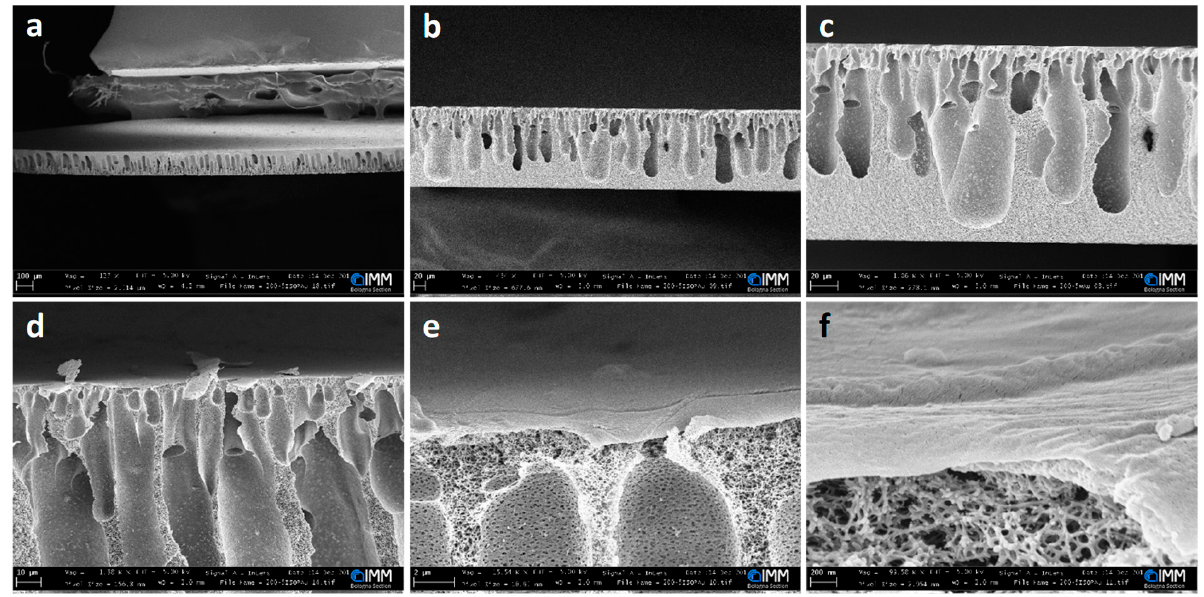
Figure 1. SEM images with different magnifications of the cross-section of a CA membrane (fabrication conditions: film applicator speed = 5 mm/s, casted solution thickness = 200 µm). The scale bars are as follows: ( a ) 100 µm, ( b ) 20 µm, ( c ) 20 µm, ( d ) 10 µm, ( e ) 2 µm, and ( f ) 200 nm.